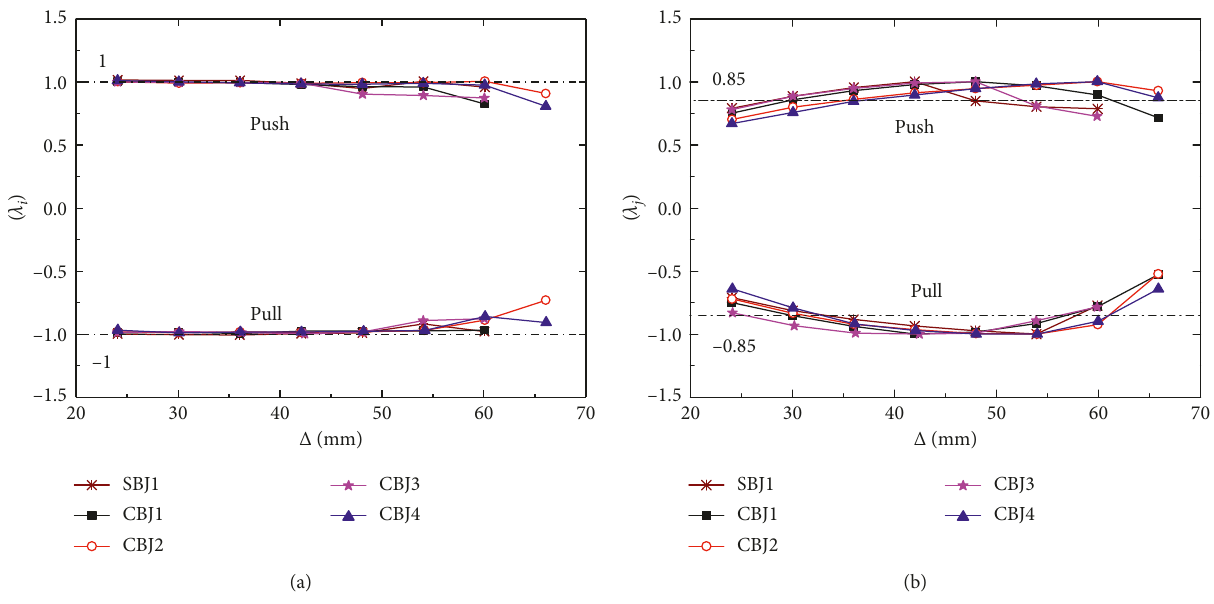
Figure 18: Strength degradation curves: (a) strength degradation at the same loading level; (b) overall strength